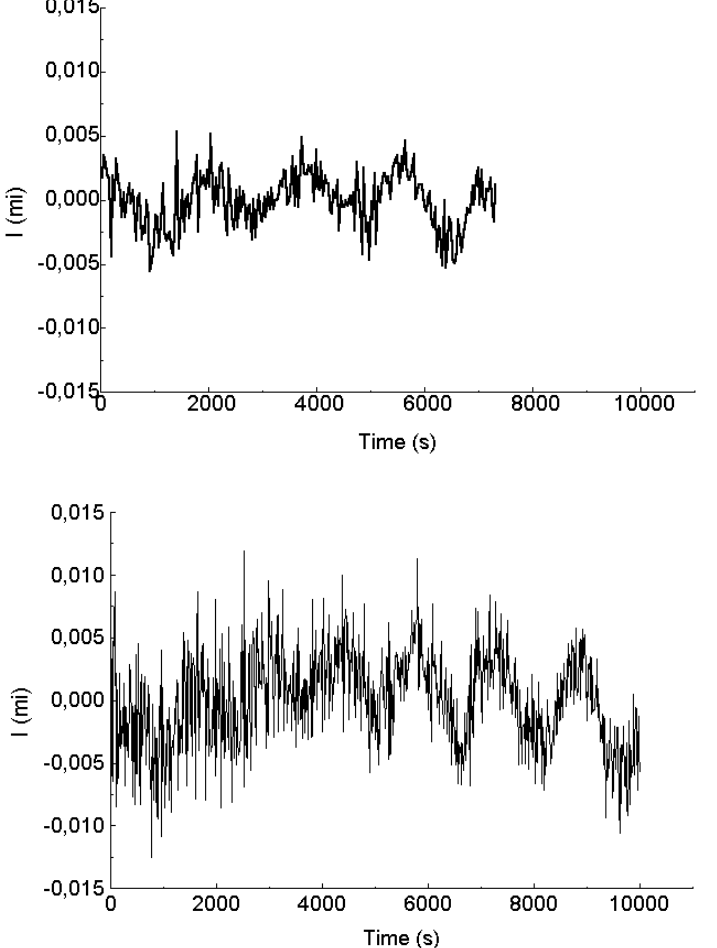
Fig. 1. NGC 246 light curves from NOT: the upper figure shows the light curve obtained July 21, and the lower is on July